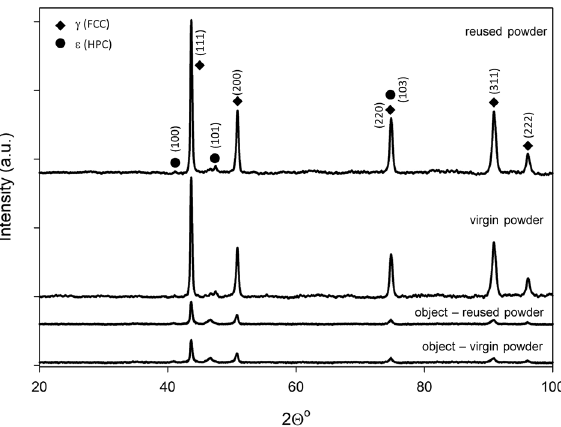
Figure 3. XRD spectra for the virgin and reused CoCr powders and the 3D objects printed from them.